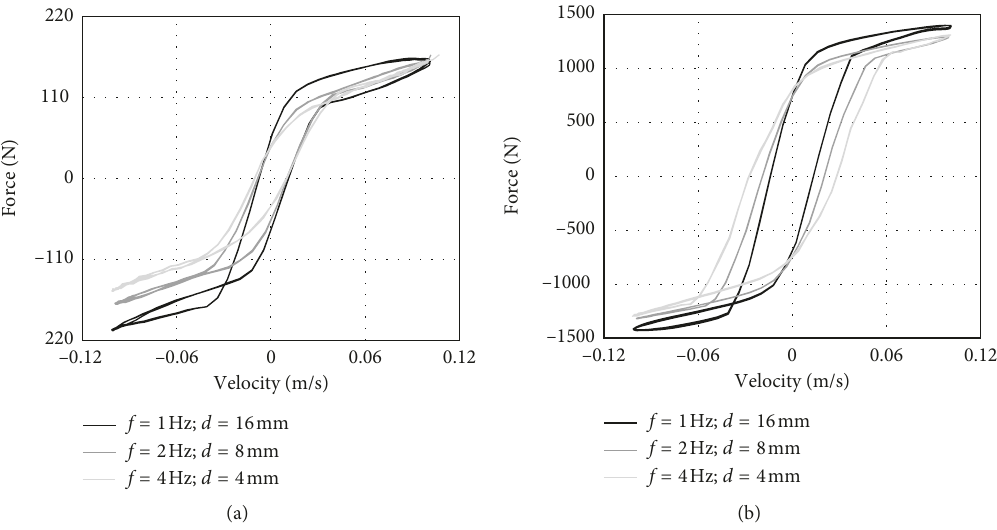
Figure 3: Force-velocity hysteresis cycles for different experimental sinusoidal tests. (a) I